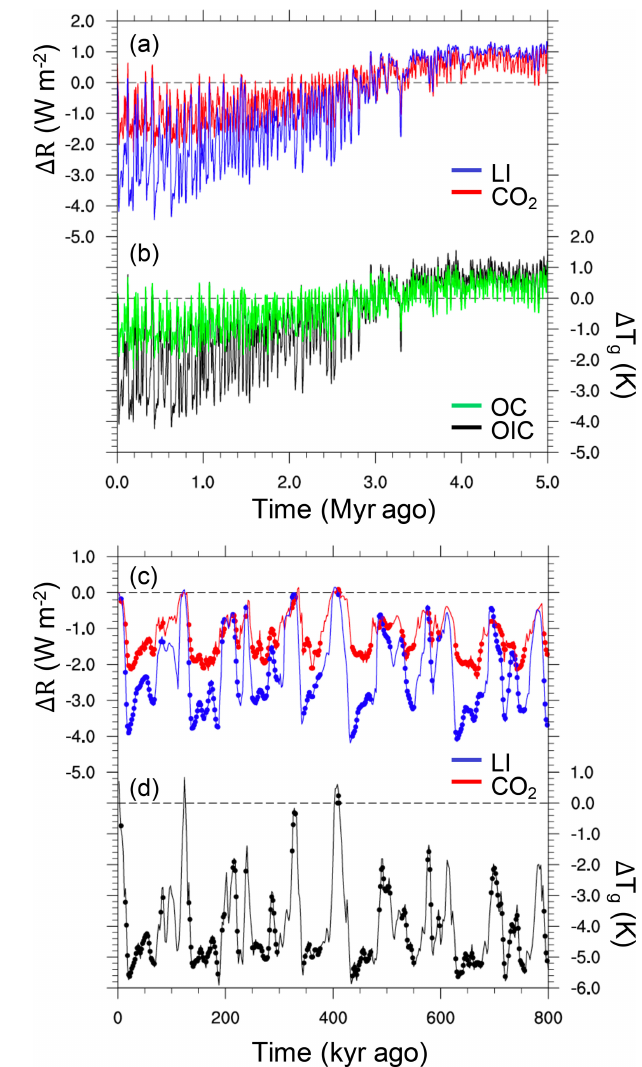
Figure 1. Time series of radiative forcing anomalies ( (cid:49)R ) caused by CO 2 (red) changes and land ice changes (blue) and global temperature anomalies ( (cid:49)T g ) with respect to PI from (a–b) the CLIMBER-2 model dataset (Stap et al., 2018a), with temperature data for experiment OIC in black and for experiment OC in green, and from (c–d) the proxy-inferred dataset (Köhler et al., 2015a), with solid lines for the whole dataset and dots for the data used in this study which exclude times with strong temperature–CO 2 diver- gence (see Sect. 4.1). Note the differing axis